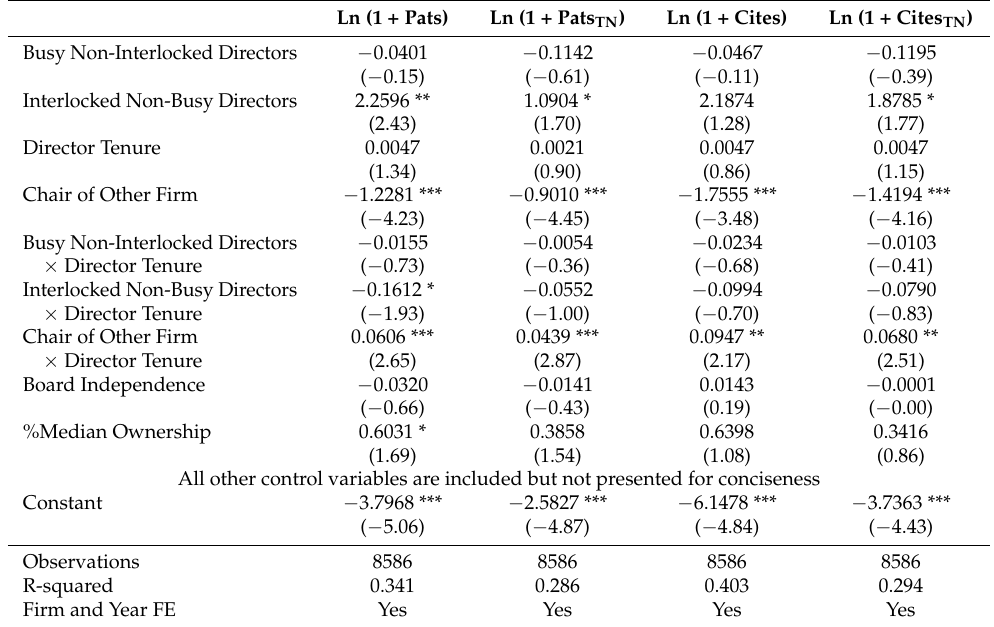
Table 11. Regressions of Innovation on the Interactions of Director Busyness and Interlocks with Entrenchment. This table presents regression results of Innovation on the interaction between Direc- tor Busyness and Entrenchment and the interaction between Director Interlocks and Entrenchment. Control variables are included in the analyses but not tabulated for conciseness. All regressions contain firm and year fixed effects. All except binary variables are winsorized at the upper and lower 1% levels. Full variable definitions are provided in the Appendix A. T-statistics are reported in parentheses. Standard errors are adjusted based on the Huber–White sandwich estimate of variances and are clustered by firm. *** indicates significance at the 1% level, ** 5% and * 10%. Ln (1 +